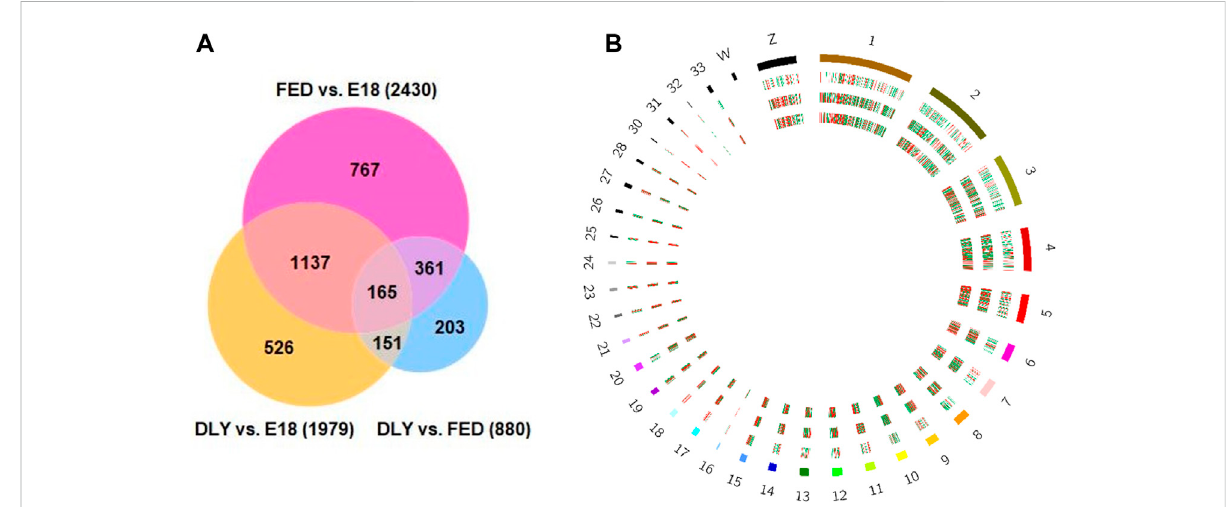
FIGURE 1 Number and genomic distribution of differentially expressed genes between E18 embryos and D2 fed-from-hatch (FED) chicks, E18 and D2 delayed-fed chicks (DLY) and between DLY and FED. (A) Venn Diagram of the number of differentially expressed genes (fold-change ≥ 2; FDR p -value ≤ 0.05) between E18 embryos and D2 fed-from-hatch (FED) chicks, E18 and D2 delayed-fed chicks (DLY) and between DLY and FED. (B) Circos plot of genomic distribution of differentially expressed genes. Red indicates upregulated genes and green indicates downregulated genes.OutermostringistheGallus galluskaryotype,followedtheDLYvs.FEDcomparison, theDLYvs.E18comparisonandtheinnermostringisthe FED vs. E18 comparison. Cicros plot was generated using the Circos tool from galaxy